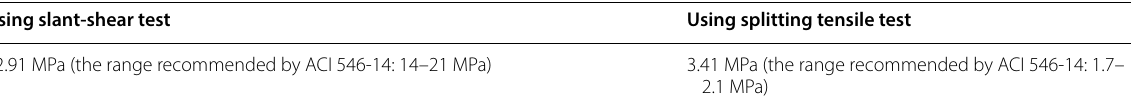
Table 6 Average bond strengths. Using slant-shear